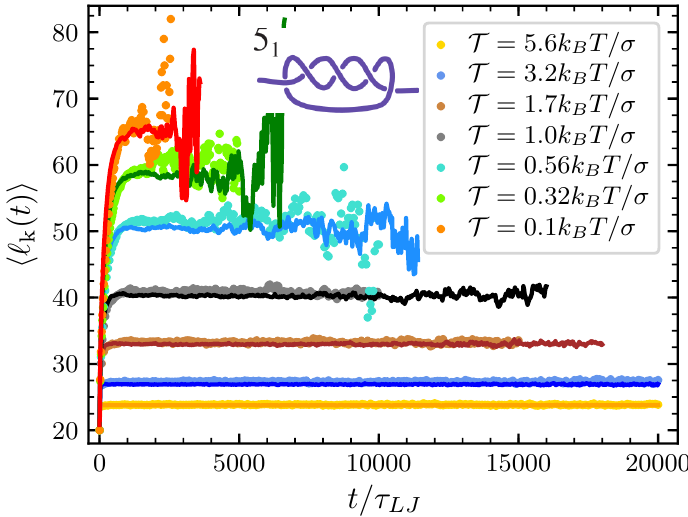
Figure 4. Average knot size of the 3 1 ( n k = 3) at the various value of time. Dots are data from MD simulations and the corresponding full lines are the prediction of the model once A c is adjusted to obtain the best agreement with MD simulations.